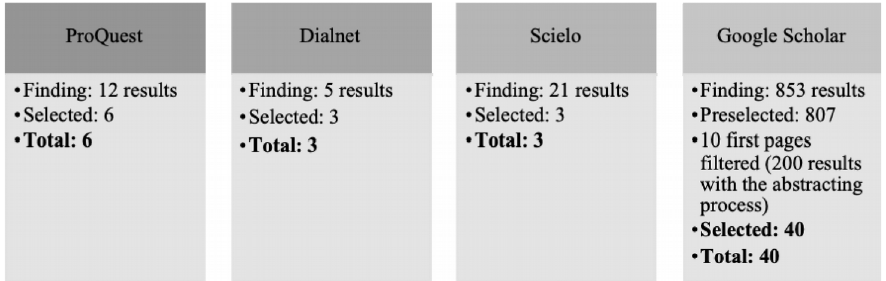
Figure 2. Characteristics of the sample